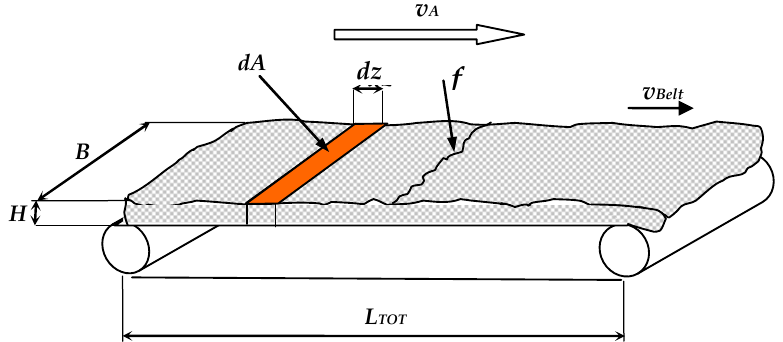
Figure 3. Conveyor-belt dryer with tangential flow in co-current: transverse dimension f ; velocity of the drying air v A ; velocity of the belt v Belt ; length of the belt L TO T ; height of the product bed H ; width of the product bed B ; infinitesimal area of the product exposed to the air dA ; infinitesimal length dz .